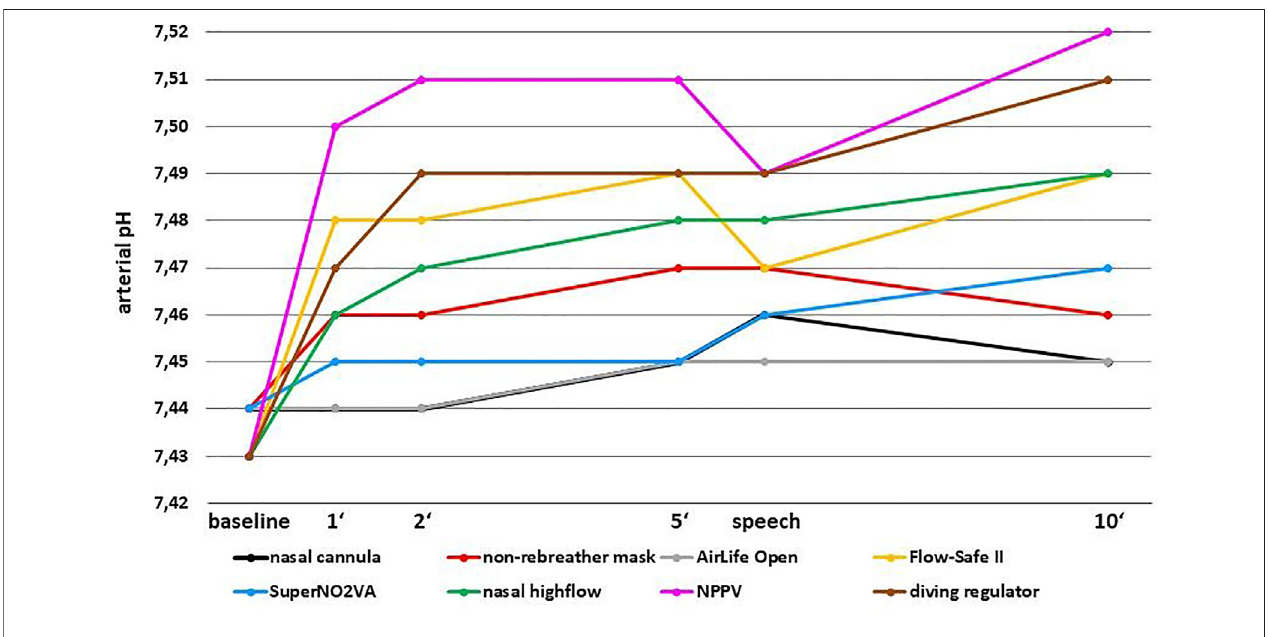
FIGURE 3 | Mean arterial pH during breathing with the different oxygen systems.